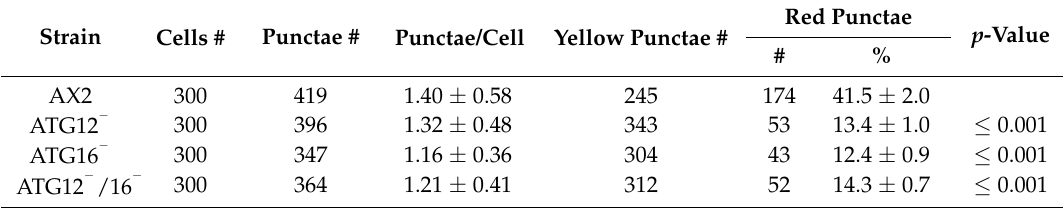
Table 2. Autolysosome maturation is less efficient in ATG12 − , ATG16 − , and ATG12 − /16 − cells. Statistical analysis was performed with the Dunn Bonferroni test implemented in R as post hoc analysis. The difference in the percentage of red punctae between NH 4 Cl-treated AX2 and the different knock-out strains is extremely significant. #,